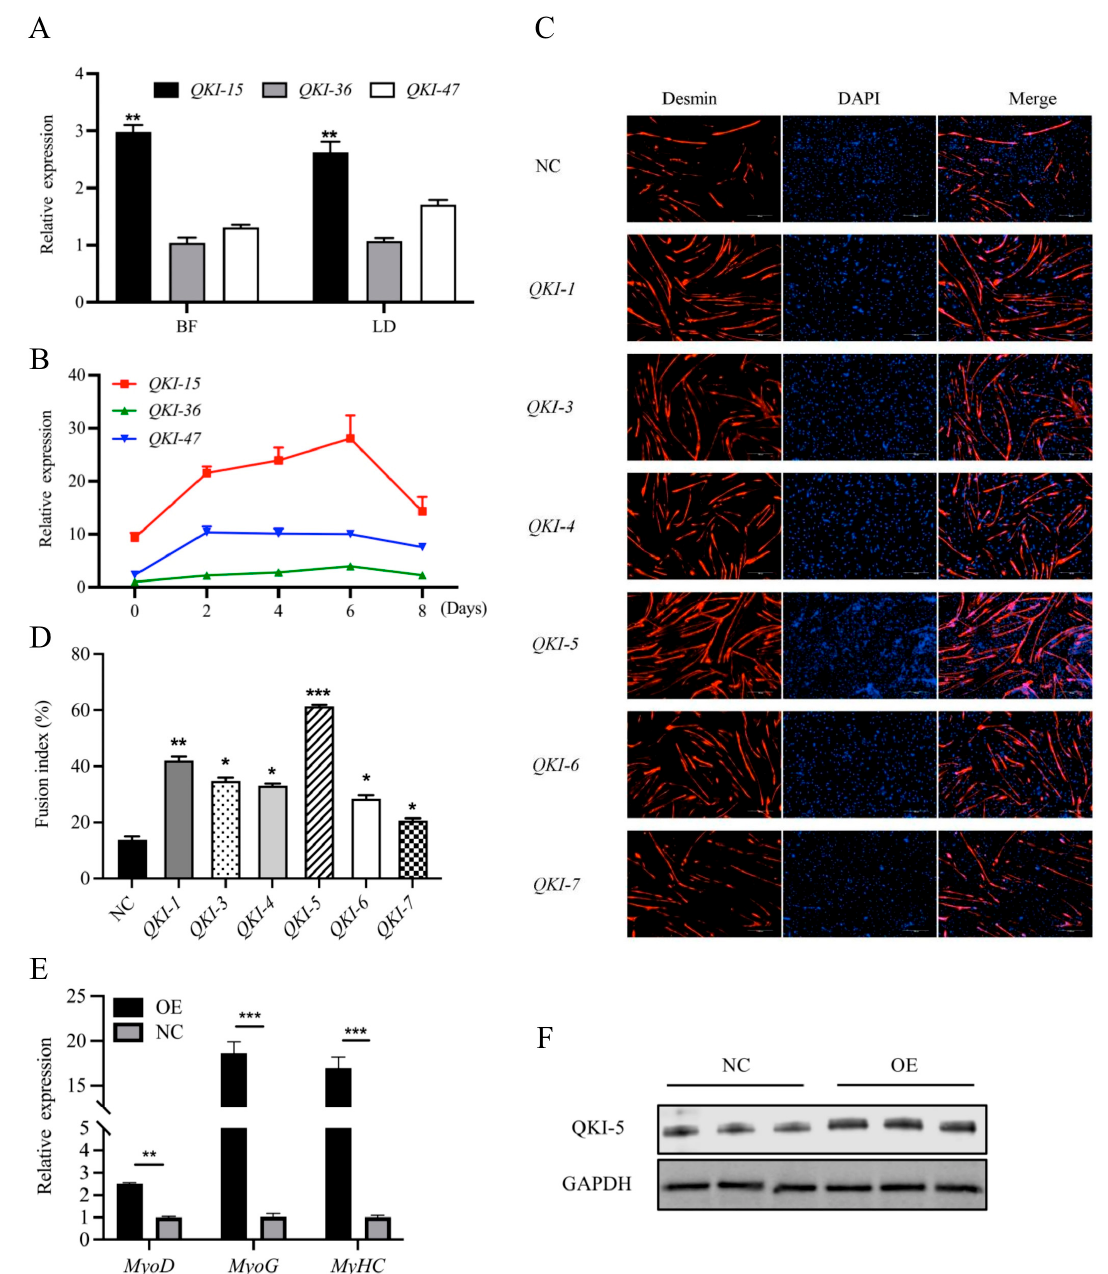
Figure 2. Expression levels of various QKI isoforms in goat-muscle tissue and myoblast differentiation. ( A ) The qPCR showing expression of different QKI isoforms in goat LD and BF muscle tissues. Data are means ± SEM; n = 6/group. ( B ) The qPCR showing expression trends of different QKI isoforms during goat-myoblast differentiation. ( C ) Immunofluorescence of goat-myotube differentiated for 6 d in presence of QKI overexpression or negative control (NC). Myotubes were fixed and stained with desmin (red) and DAPI (blue). Scale bar = 100 µ m. ( D ) Fusion indices of myotubes from ( C ) calculated as % of nuclei within myotubes. Control group was NC (*** p < 0.001; ** p < 0.01; * p < 0.05). ( E ) Expression analysis of marker genes during myoblast differentiation. ( F ) Protein expression in QKI overexpression (OE) and negative control (NC) groups. GAPDH: internal reference gene.